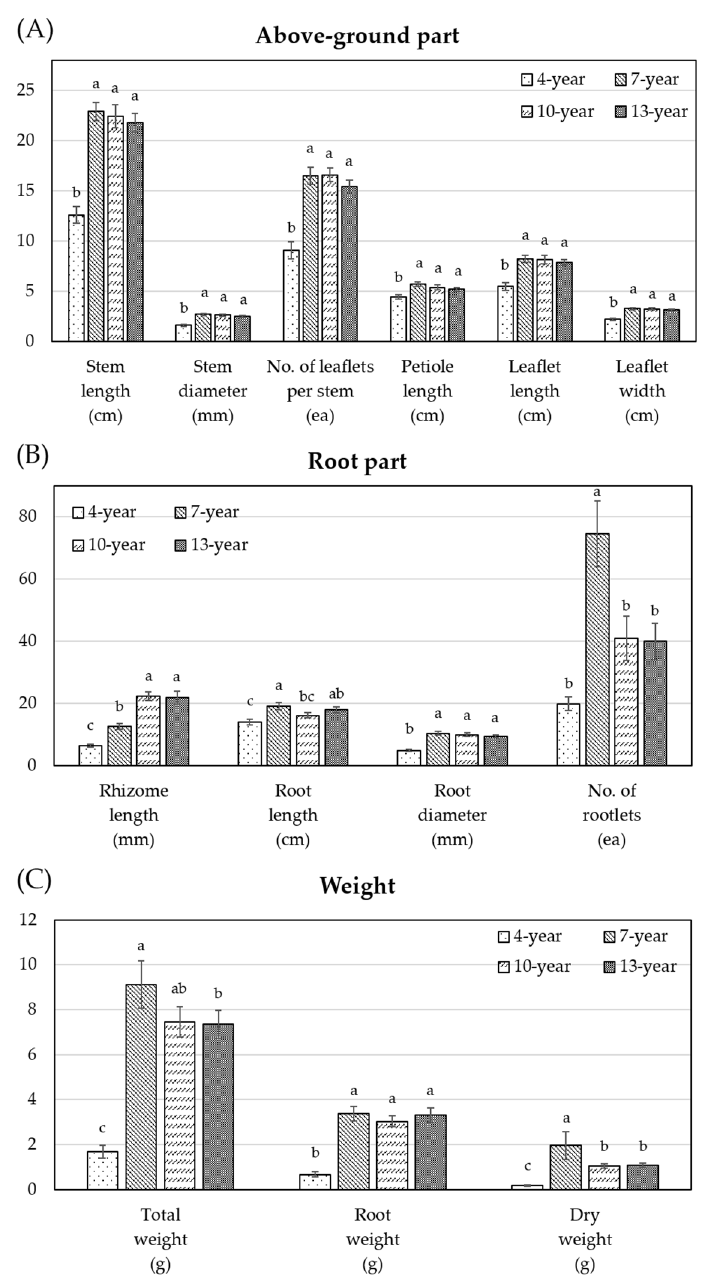
Figure 3. Growth characteristics of wild-simulated ginseng with different ages. ( A ) Above-ground part, ( B ) Root part, ( C ) Weight. Value in each column with different letters are statistically differences ( p < 0.05) among the treatments according to Tukey’s test (n = 25).